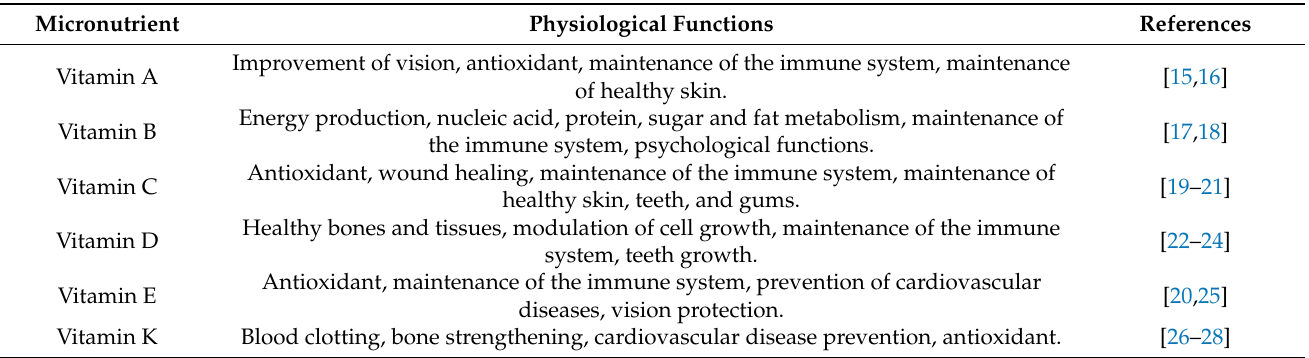
Table 1. Physiological functions of vitamins in humans. Micronutrient Physiological Functions